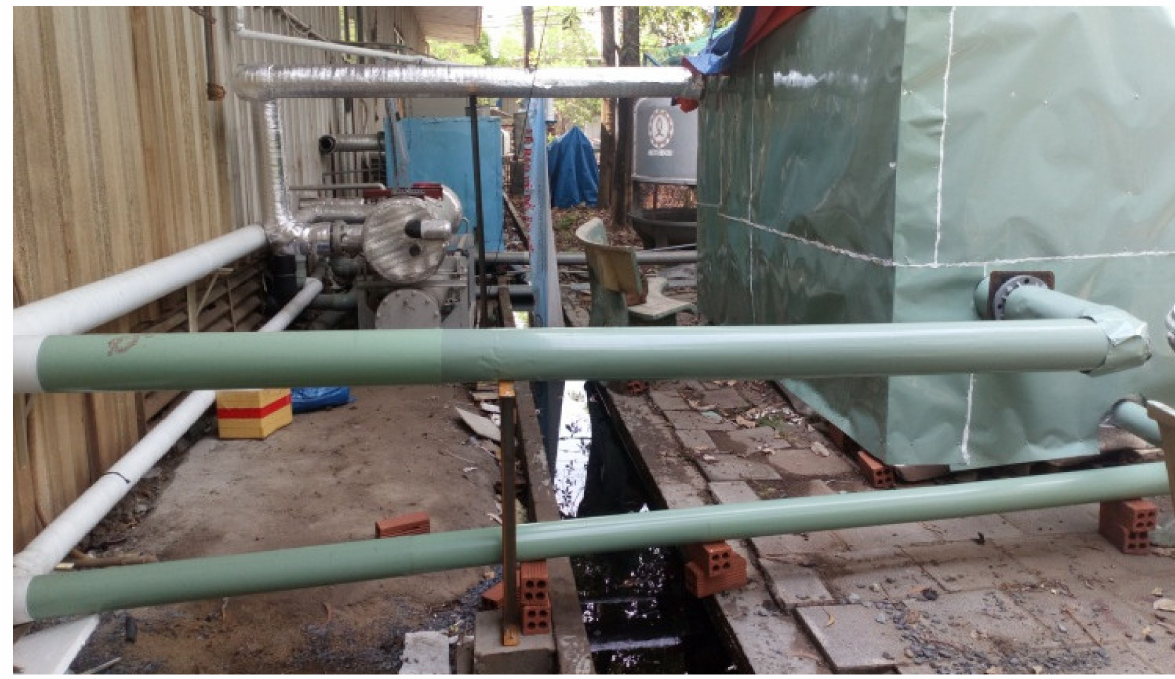
Figure 5. Photograph of the cold storage tank integrated into the